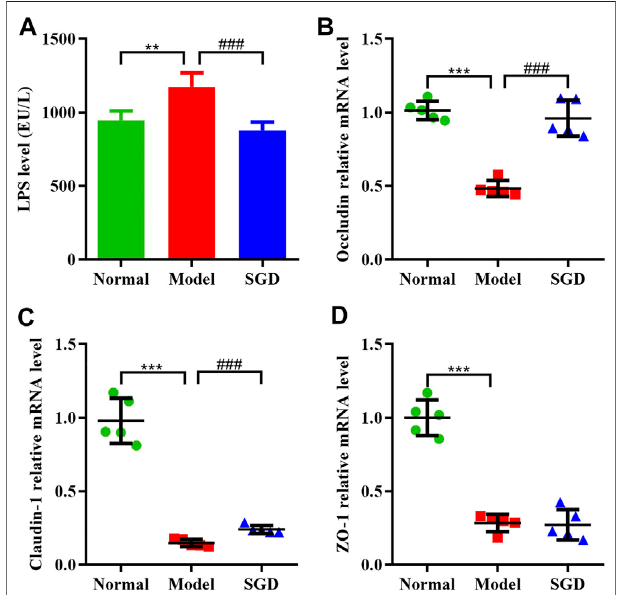
FIGURE 4 | SGD treatment reduced the serum LPS level and ameliorated the intestinal barrier function in PCOS rats. (A) Serum levels of LPS were determined by using ELISA kits ( n (cid:1) 10). (B – D) The mRNA levels of tight junction proteins gene including occluding (B) , claudin-1 (C) , and ZO-1 (D) inratsileummucosawerequantitatedbyreal-time PCR( n (cid:1) 5).Data werepresentedasmean ± SEM.** p < 0.01and*** p < 0.001vs.normalgroup, ### p < 0.001 vs. PCOS model